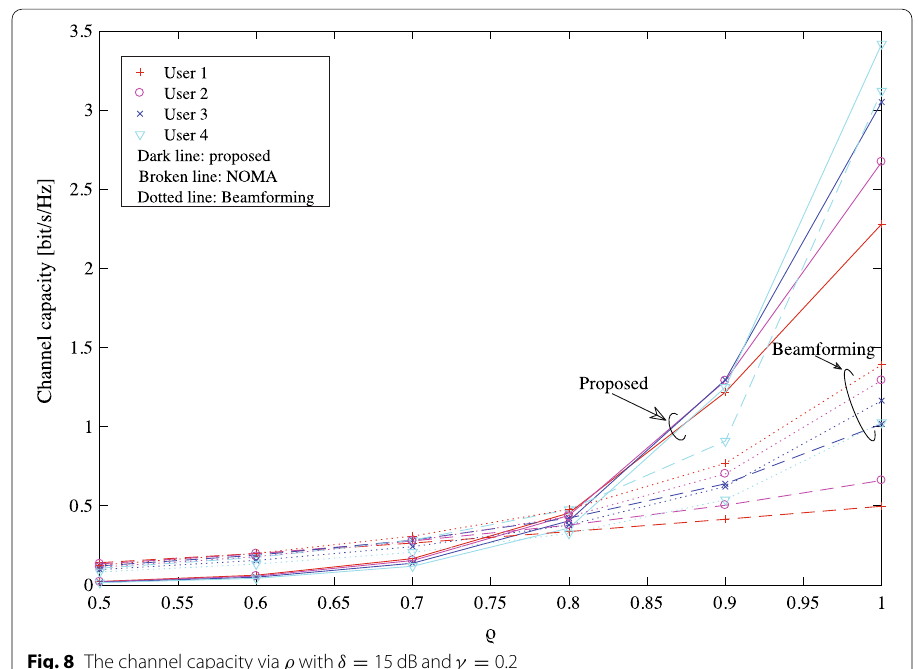
Fig. 8 The channel capacity via ρ with δ = 15dB and γ =